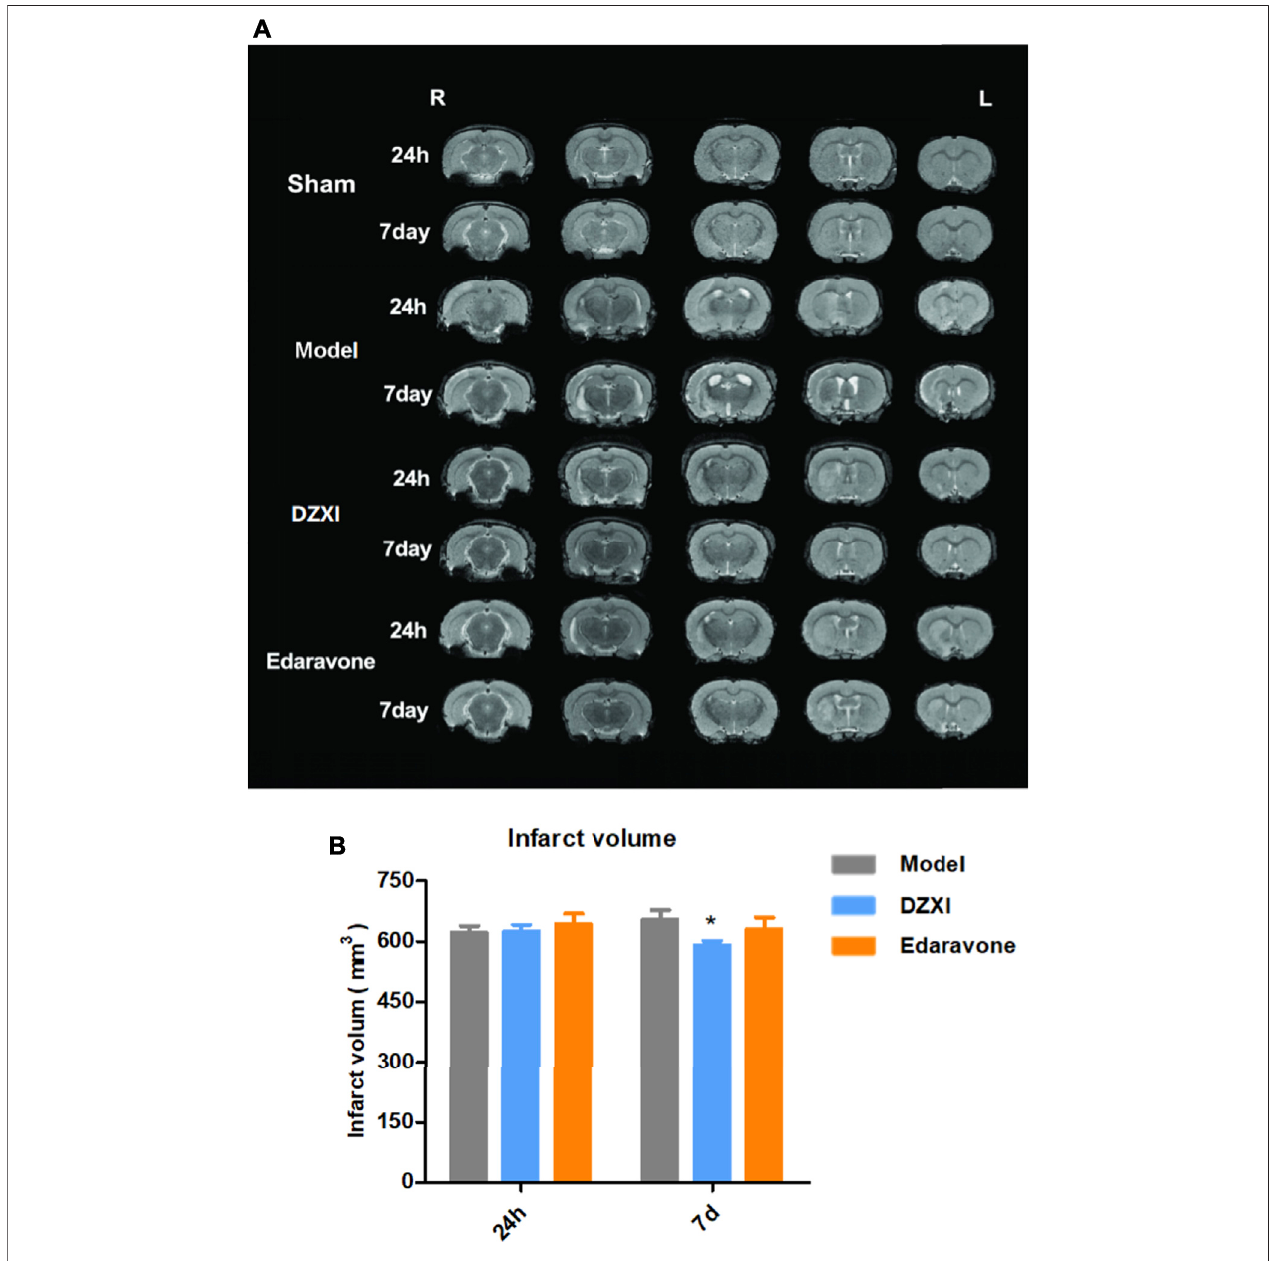
FIGURE5| TheT2-weightedMRIimagesandinfarctvolumesanalysisresults. (A) RepresentativeT2-weightedMRIimagesofMCAOmodel,DZXI,andedaravone groups at 24th h and 7th day of treatments. The white regions are infarct regions. (B) The infarct volumes of model, DZXI and edaravone groups at 24th h and 7 th d of treatments. The differences between groups were analyzed by two-way ANOVA followed by the Bonferroni test. p p < 0.05, DZXI group vs model group at the same time point.